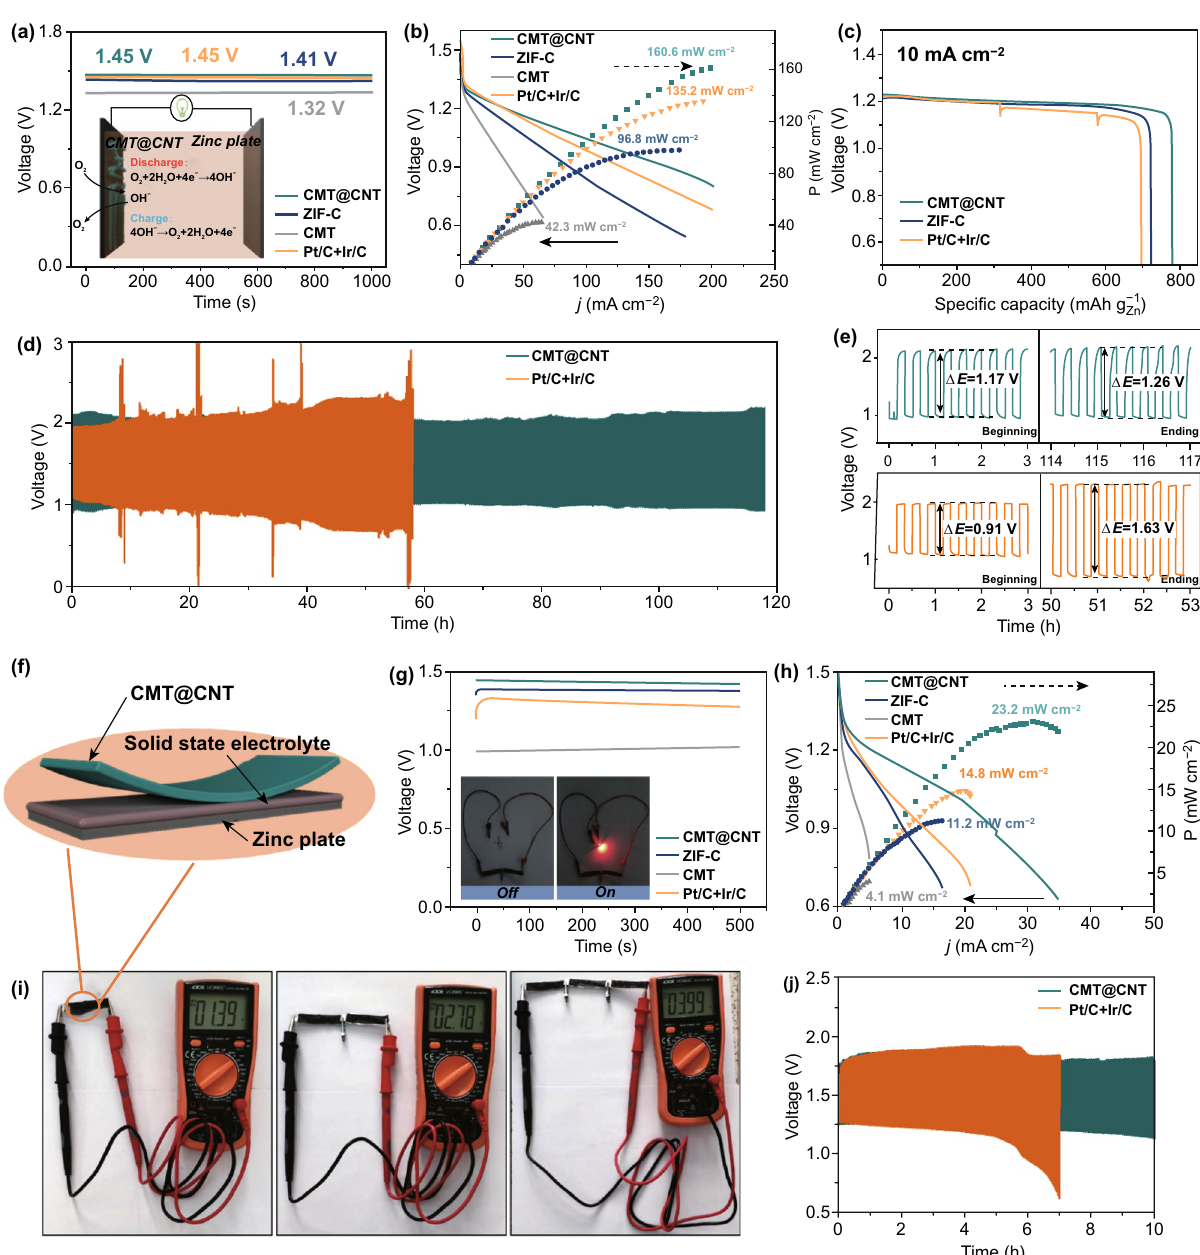
Fig. 5 CMT@CNT, ZIF-C, CMT, and Pt/C + Ir/C-based ZABs and all-solid-state ZABs performance. a Open-circuit plots (inset: a schematic illustration of ZAB based on CMT@CNT). b Discharge polarization curves and the corresponding power density plots. c Specific capacity plots of CMT@CNT, ZIF-C, and Pt/C + Ir/C-based ZABs. d,e Discharge and charge curves of CMT@CNT and Pt/C + Ir/C-based ZABs. f A sche- matic illustration of all-solid-state ZAB based on CMT@CNT. g Open-circuit plots (inset: photograph of a red light-emitting diode powered by two CMT@CNT-based all-solid-state ZABs connected in series) and h discharge polarization curves and the corresponding power density plots. i Photograph of one, two, and three CMT@CNT-based all-solid-state ZABs in series displaying measured open-circuit voltage. j Discharge and charge curves of CMT@CNT-based and Pt/C + Ir/C-based all-solid-state